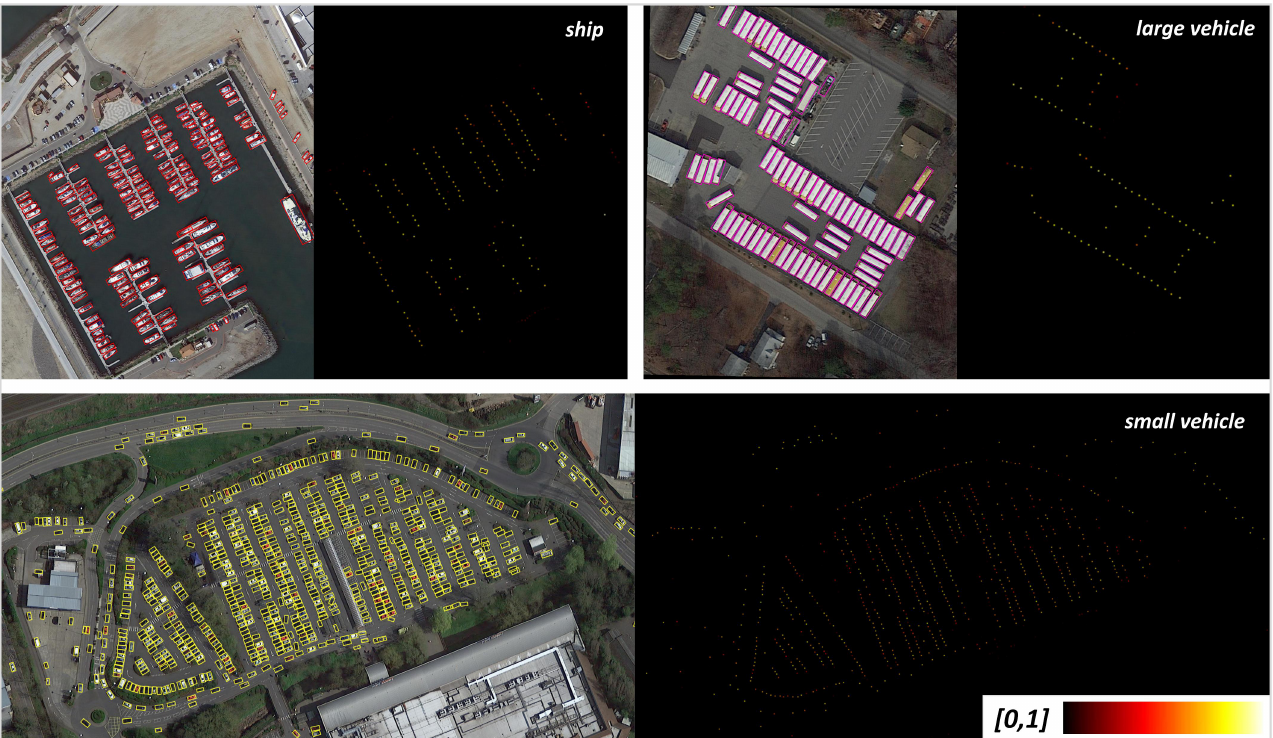
Figure 10. Visualization of predicted center heatmaps for some